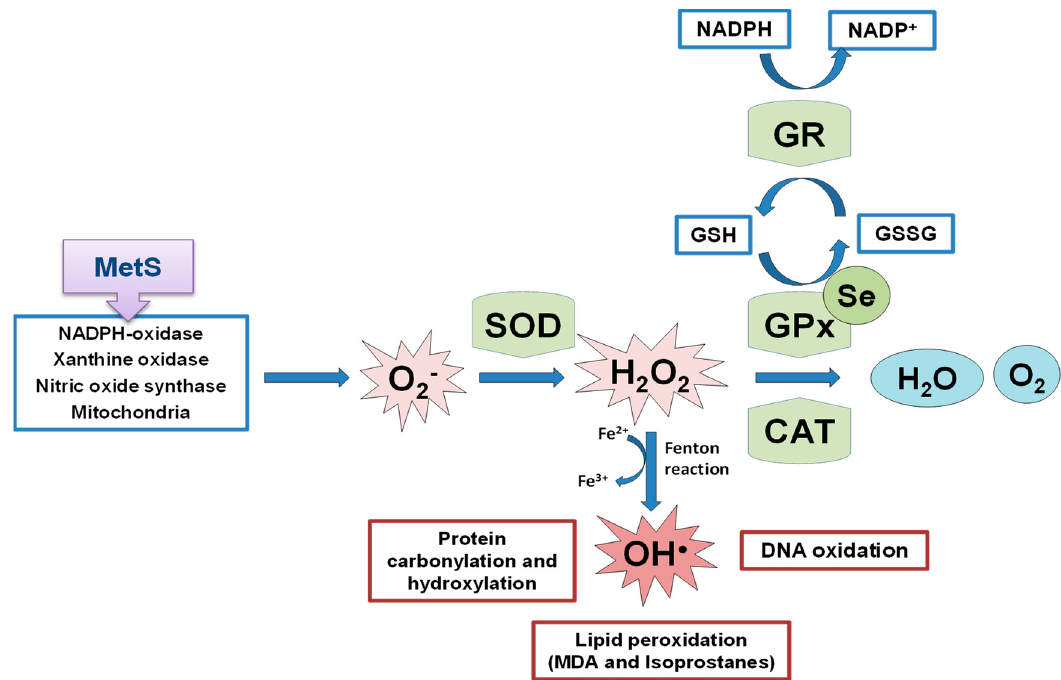
Figure 2. Schematic representation of endogenous antioxidant enzyme systems, the effect of the selenoprotein GPxs against the formed ROS. MetS implication in ROS generation. SOD: superoxide dismutase; GPx: glutathione peroxidase; CAT: catalase; GR: glutathione reductase; GSH: reduced glutathione; GSSG: oxidized glutathione; MDA: malondialdehyde.